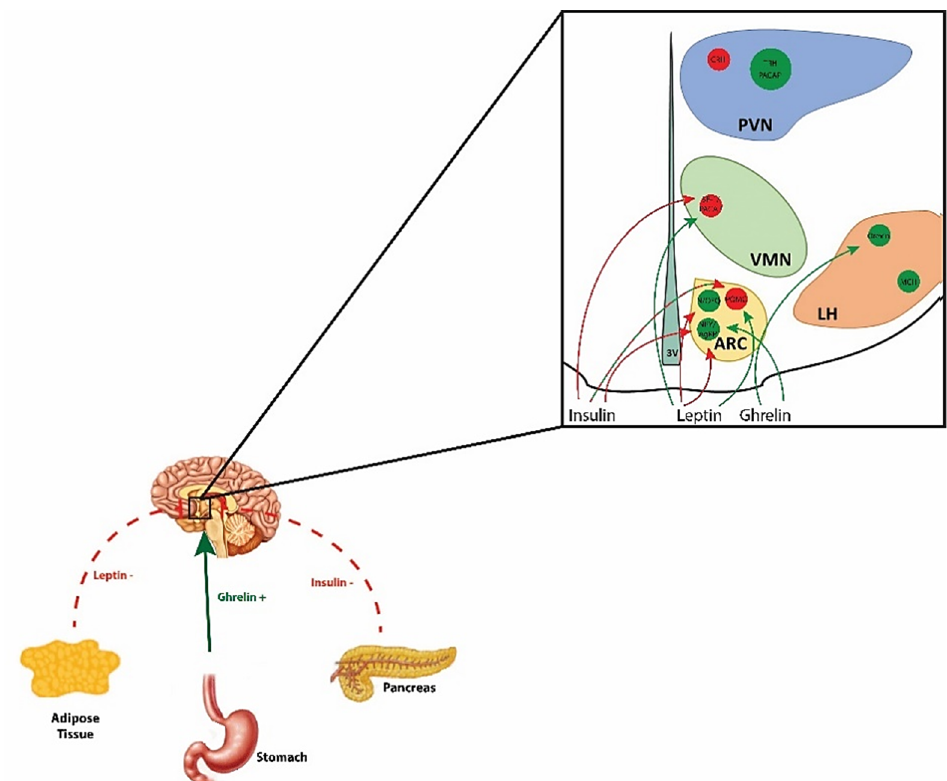
Figure 1. Schematic diagram illustrating the interplay between peripheral hormones and the homeostatic energy balance circuitry. Hormones like leptin and insulin released from adipose tissue and the endocrine pancreas, respectively, exert anorexigenic effects, whereas ghrelin released from the gastric mucosa exerts orexigenic effects. Leptin’s appetite-suppressing actions are mediated via excitatory effects on anorexigenic POMC and SF-1/PACAP neurons, as well as inhibitory effects on orexigenic NPY/AgRP and N/OFQ neurons. Insulin also inhibits NPY/AgRP neurons and, paradoxically, SF-1/PACAP neurons as well. Insulin’s effects on POMC neurons are dependent upon prevailing levels of tyrosine protein phosphatases. On the other hand, ghrelin’s appetite-promoting effects are due to its excitatory effects on NPY/AgRP and orexin neurons.